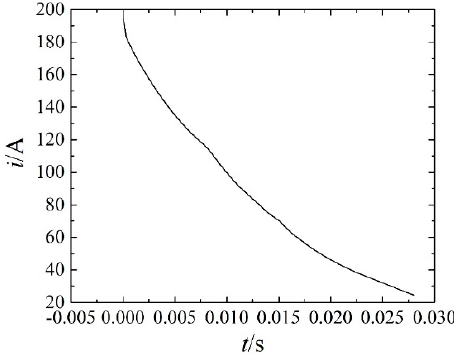
Figure 11. Arc current curve (DC 1500 V).